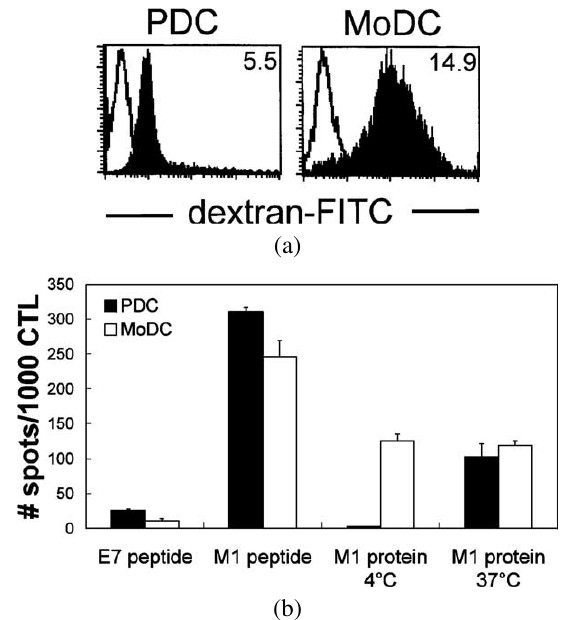
Fig. 3. (a) Analysis of dextran-FITC uptake by PDC and MoDC. The ratio of the mean fluorescence intensity of cells incubated with dex- tran-FITC at 37 ◦ C and cells incubated on ice is given (mean fluo- rescence index, MFI). (b) IFN γ ELISPOT assay of M1 specific CTL clone stimulated with PDC loaded with recombinant M1 protein. The number or specific spots per 1000 CTL are